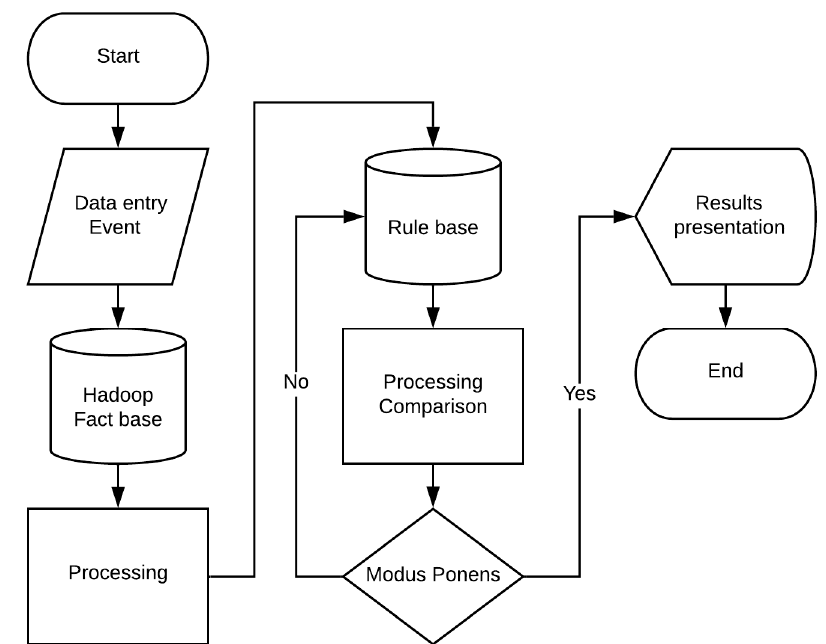
Figure 8. Block diagram, rule-based recommender system operation.